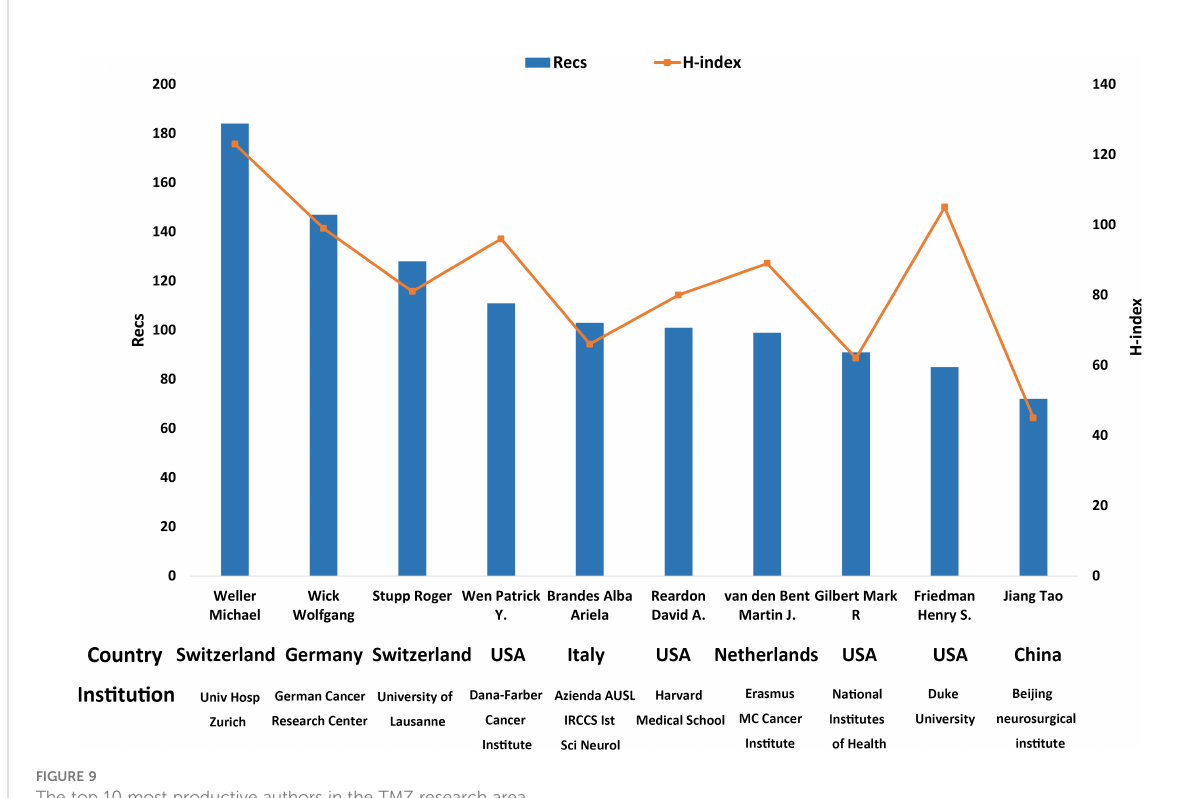
FIGURE 9 The top 10 most productive authors in the TMZ research area.